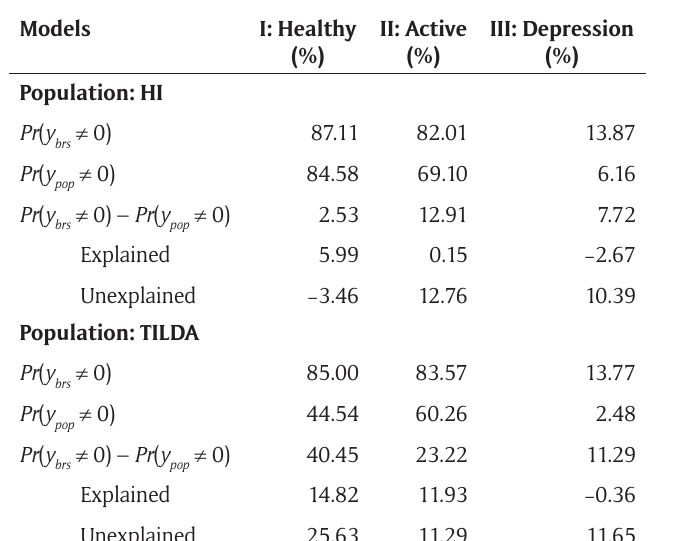
Table 5: Blinder-Oaxaca decomposition of health and well-being outcomes using Healthy Ireland Survey (HI) and The Irish Longitudinal Study on Ageing